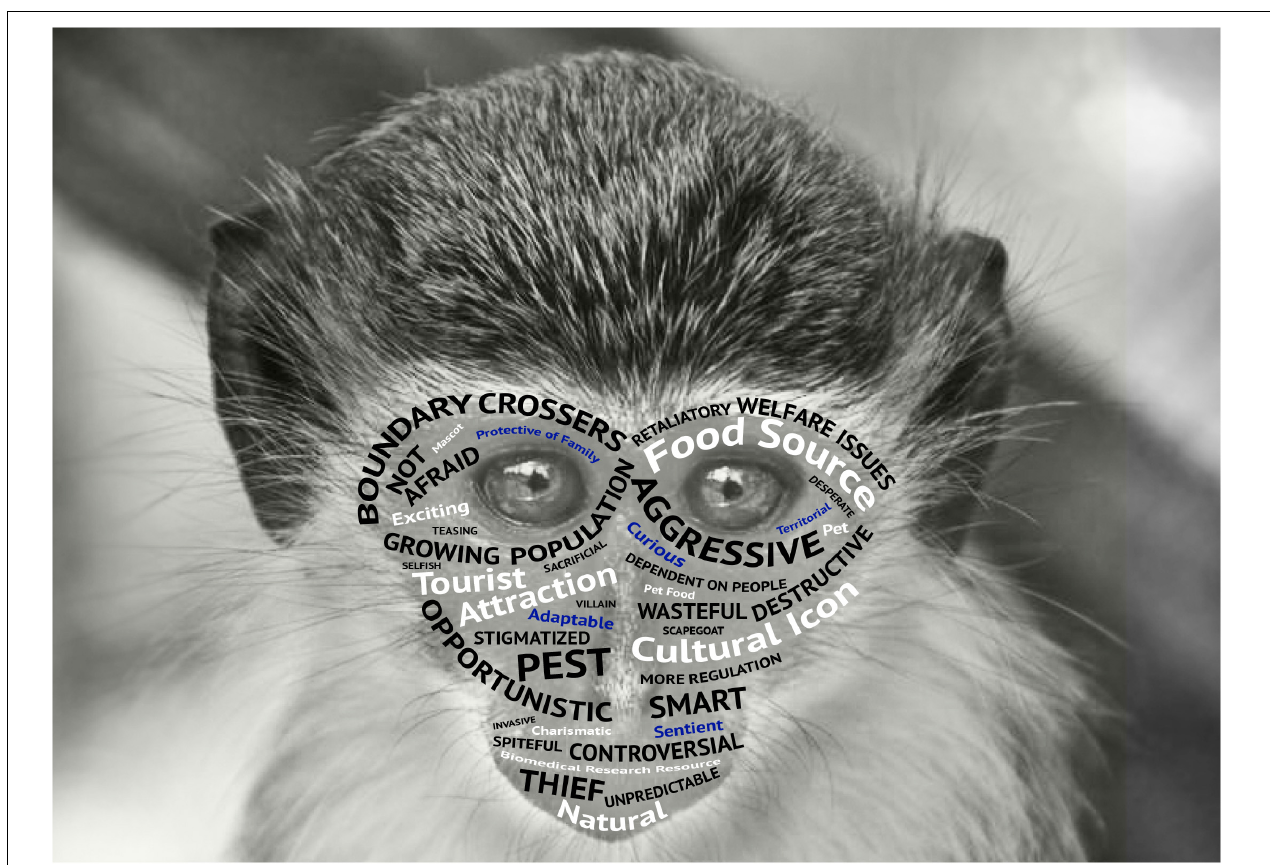
FIGURE 1 | Text portrait of an African green monkey was generated by manually extracting all monkey descriptors from the transcripts of the stakeholder interviews, thematically clustering the descriptors ( n = 40) and enumerating them based on frequency of use. A word cloud was generated and converted into a text portrait using Adobe Illustrator and Adobe Photoshop, where the size of each variable represents the relative frequency with which it occurred in the transcripts. Descriptors were assigned valence: positive descriptors are shown in white; negative in black and neutral in blue. Original photo credit: Meghan F.